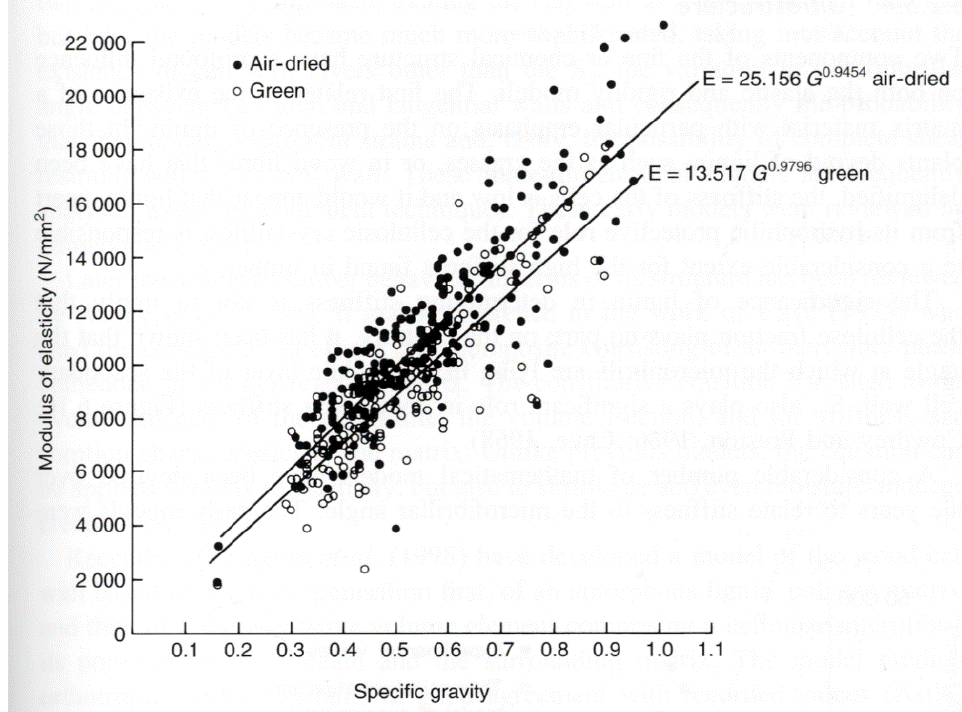
Figure 21. Plot of the longitudinal modulus of elasticity against specific gravity for more than 200 species of tree tested in green and dry states. From [92].